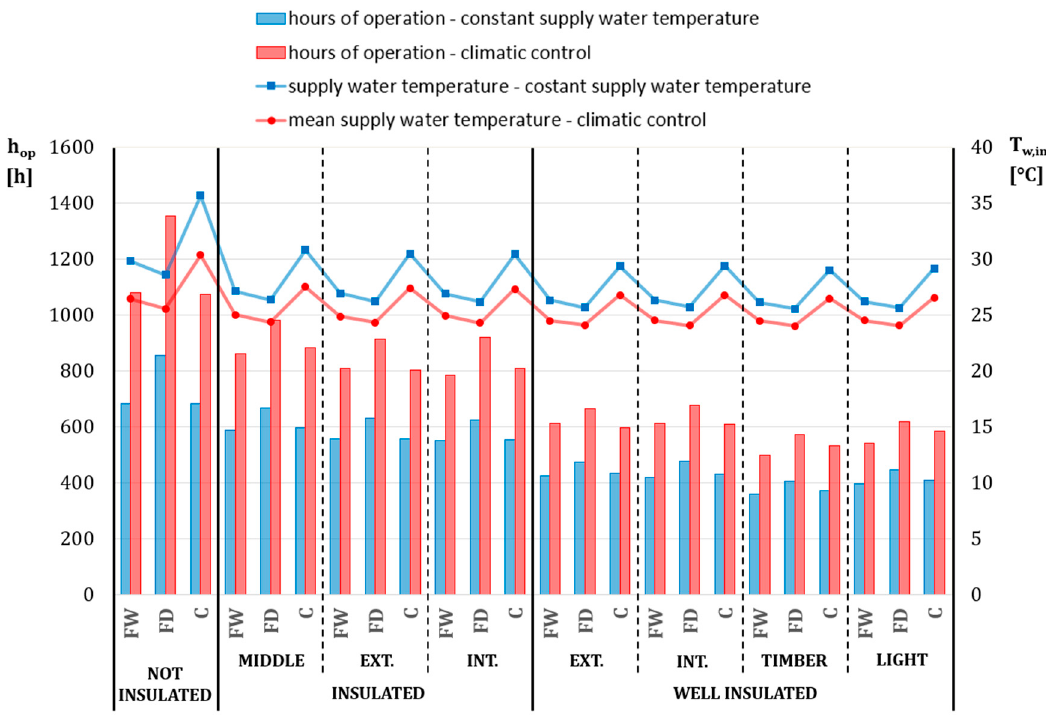
Figure 8. Hours of operation of the radiant systems and mean value of the supply water temperature in the different cases.